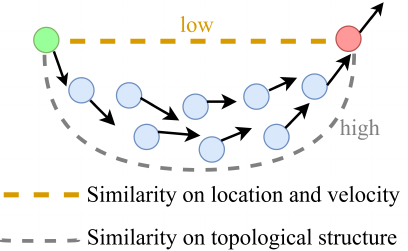
Figure 1. Illustration of topological relevance. The red data sample and the green data sample show a low similarity on spatial velocity, but they maintain high topological relevance to each